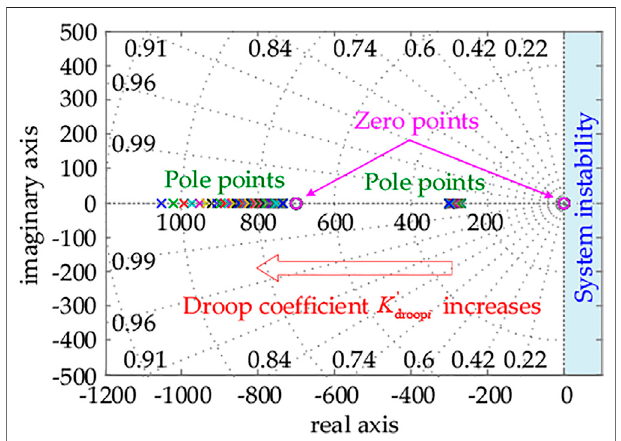
FIGURE 6 | Zero-pole distribution map of T ( s ) under droop coef fi cient variation.